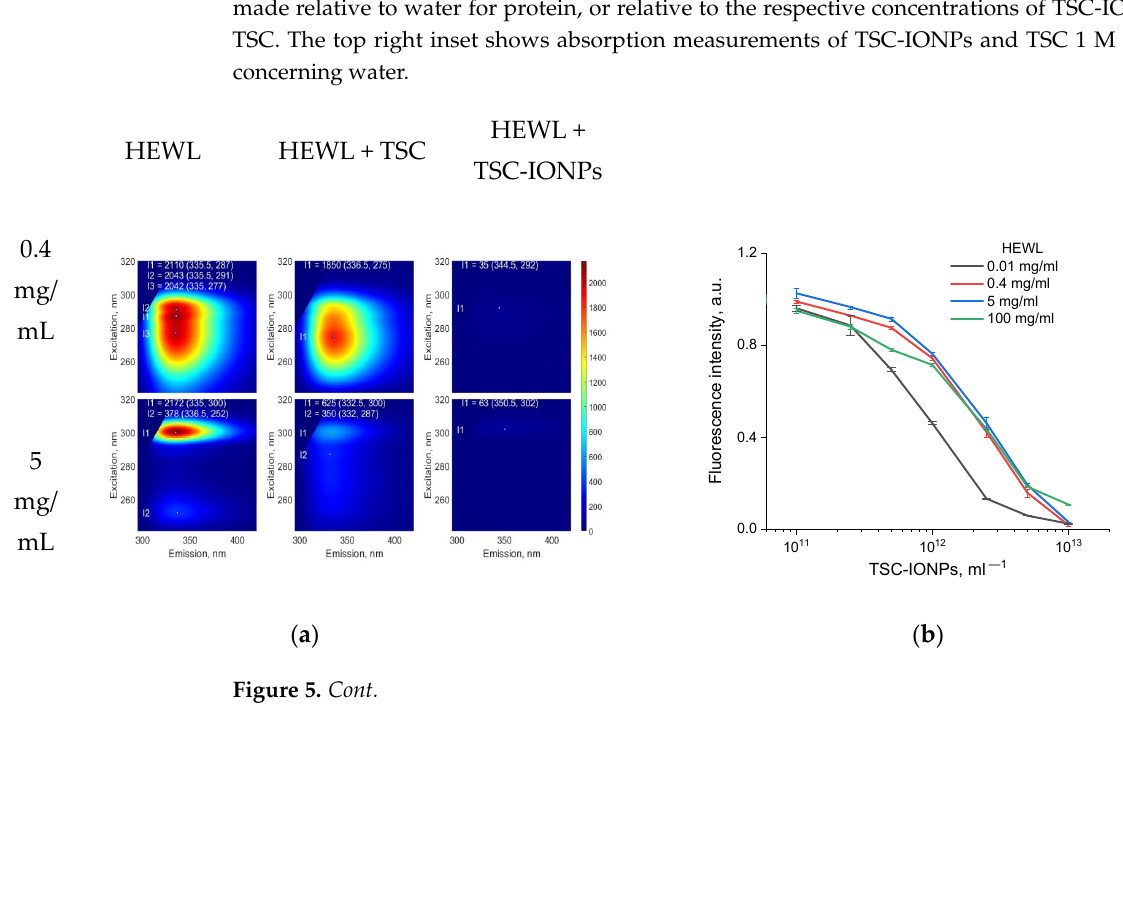
( f ) Figure 5. ( a ) Fluorescence for HEWL (0.4 and 5 mg/mL), HEWL with TSC (1 M), and HEWL with TSC-IONPs (10 13 NPs/mL). The points show the positions of the maxima. The intensities and coor-